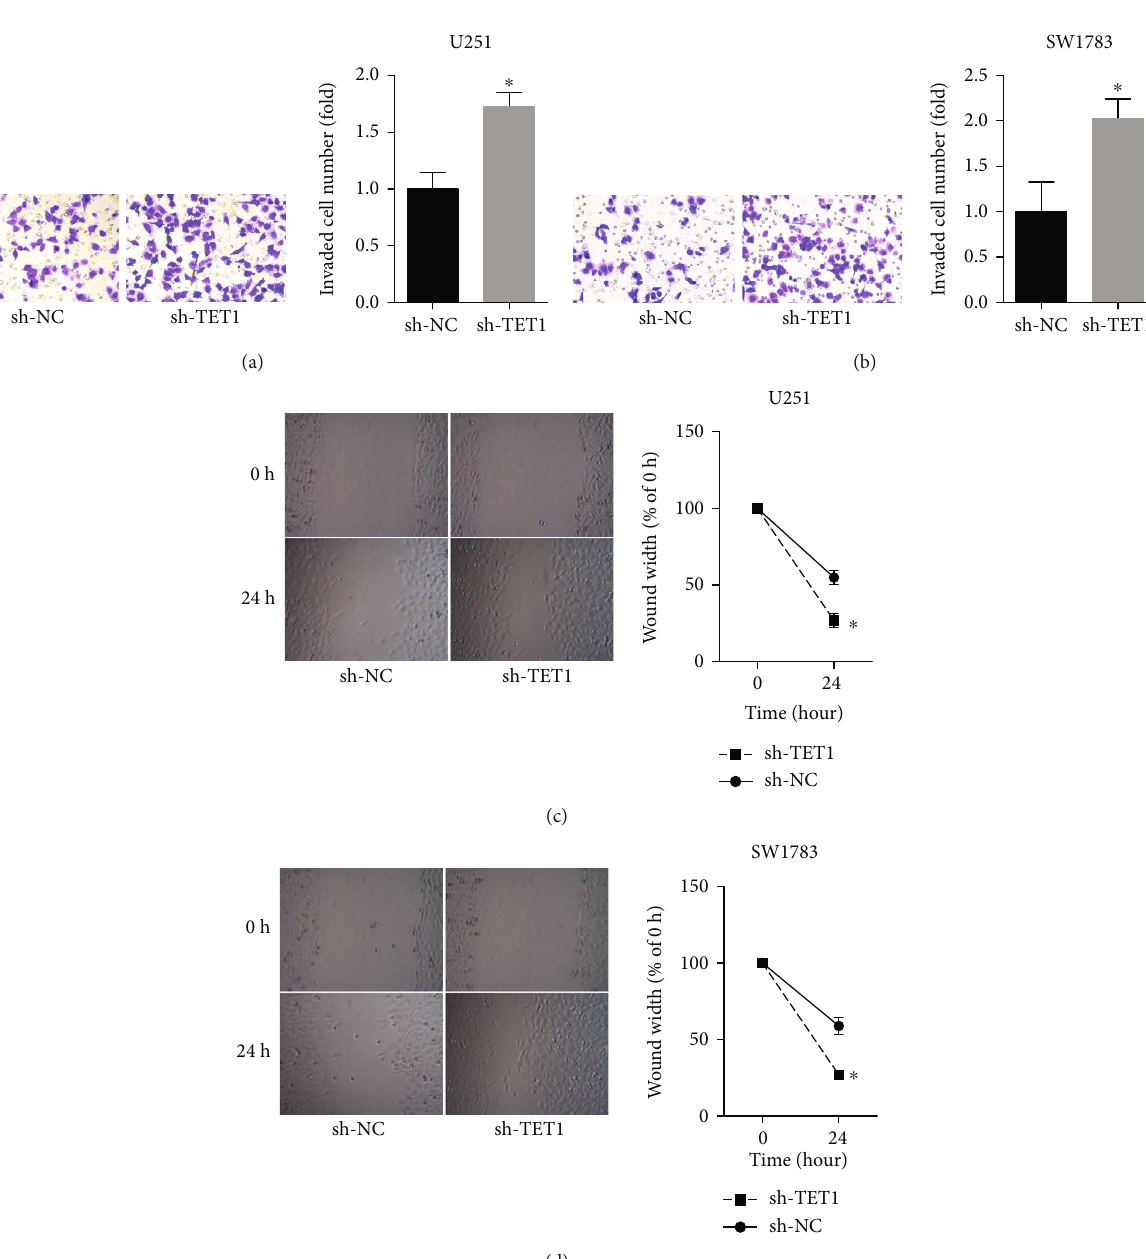
Figure 3: Downregulation of TET1 promoted the migration and invasion of U251 and SW1783 cells. (a, b) Transwell was used to detect the invasion of U251 and SW1783 cells. (c, d) Wound healing assay was adopted to determine the migration of U251 and SW1783 cells. ∗ P < 0 : 05